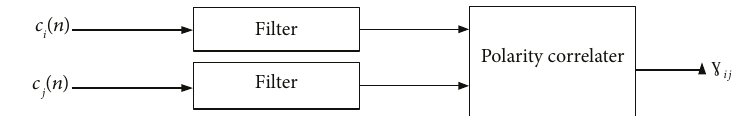
Figure 6: The proposed identi fi cation system.